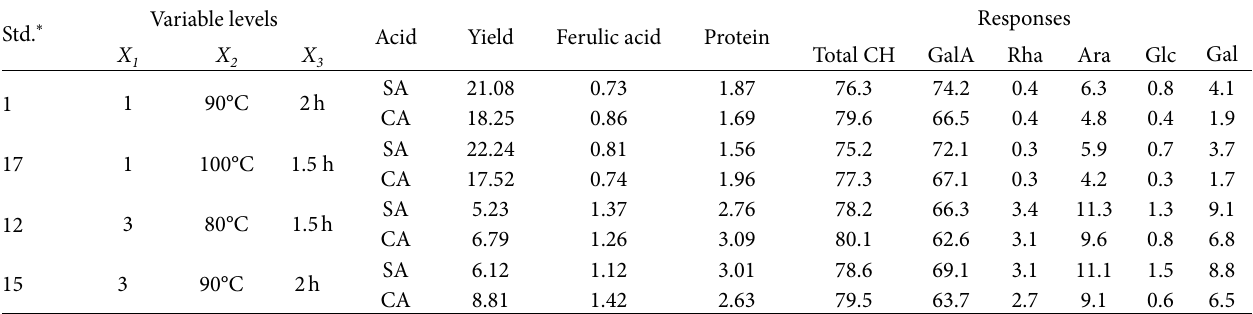
Table 4: Yield and chemical composition of pectins extracted by SA and CA from sugar beet pulp